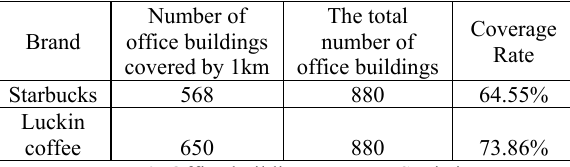
Figure 6. The coverage of Luckin coffee in the business circle.